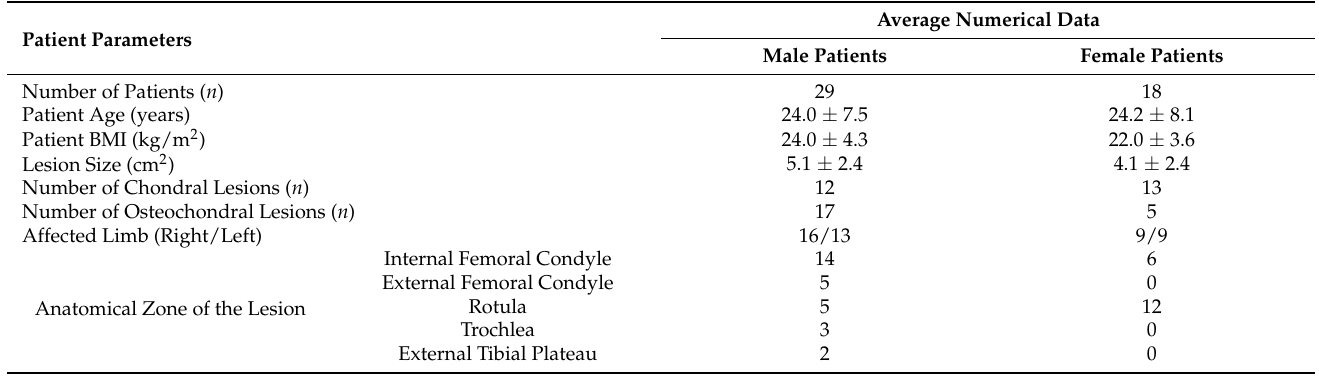
Table 1. Overview of patient ( n = 47) demographic data and injury specificities, related to autol- ogous HAC therapeutic products manufactured for ACI treatment between September 2017 and December 2021. The data are presented as numerical averages, assorted with the corresponding standard deviations. ACI, autologous chondrocyte implantation; BMI, body mass index; HAC, human articular chondrocytes.